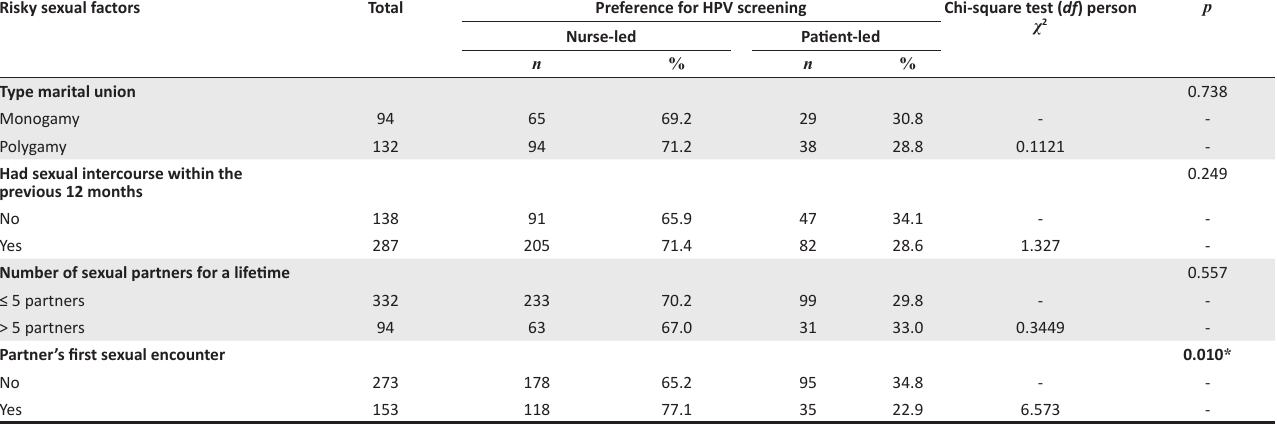
TABLE 3: Chi-square analysis of risky sexual factors associated with preference for human papilloma virus sample collection procedure among women living with HIV at a rural HIV clinic. Risky sexual